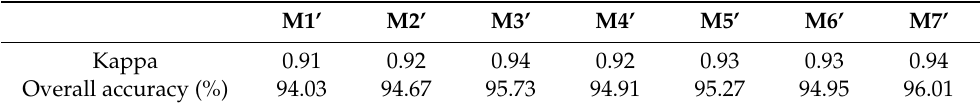
Table 5. Accuracy results for the object-based classification